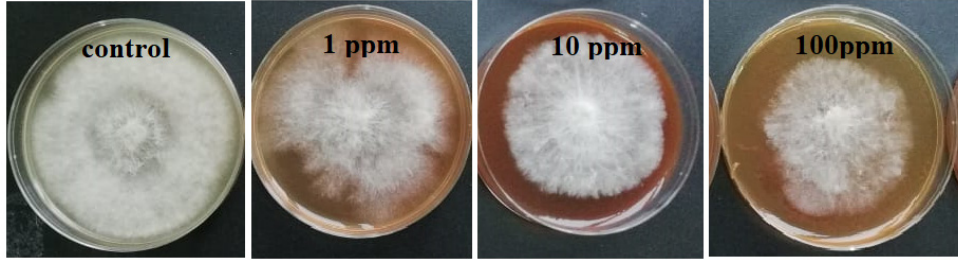
Figure 2. Effect of different concentrations of Ag NP on the growth of B. cinerea after 9 days: control and treatments with Ag NPs of 0 (as control) 1, 10, and 100 ppm concentrations, agar dilution method.